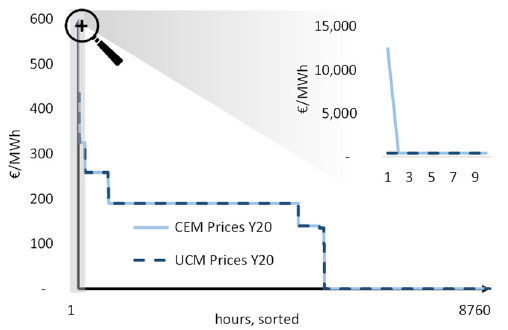
Figure 4. Price duration curves including (CEM) and without scarcity prices (UCM).